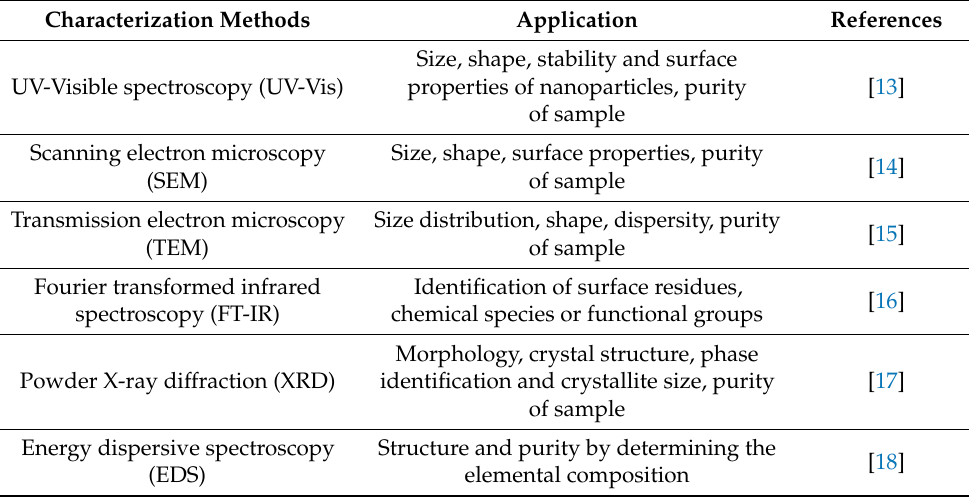
Table 1. Methods used for AgNP